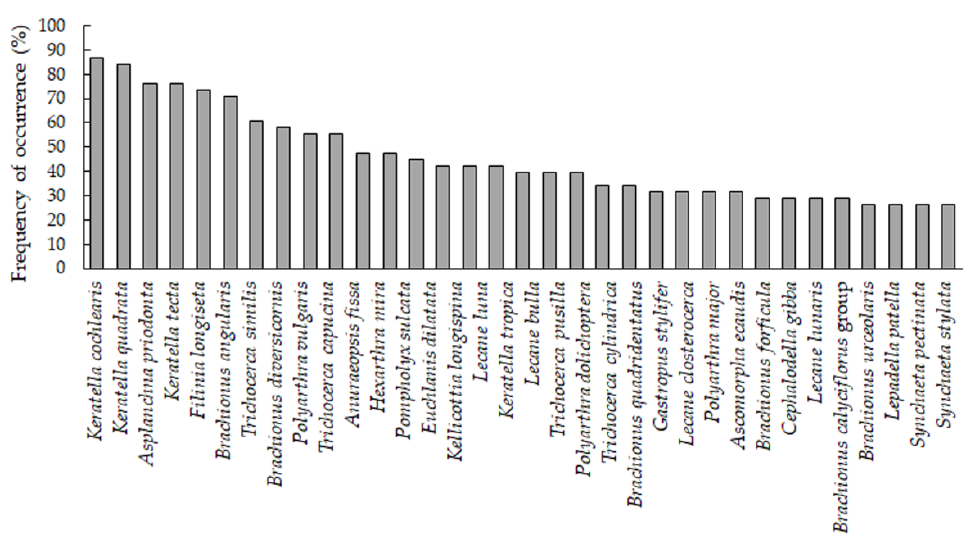
Figure 2. Species of rotifers recorded in Greek waterbodies having a frequency of occurrence over 25%.